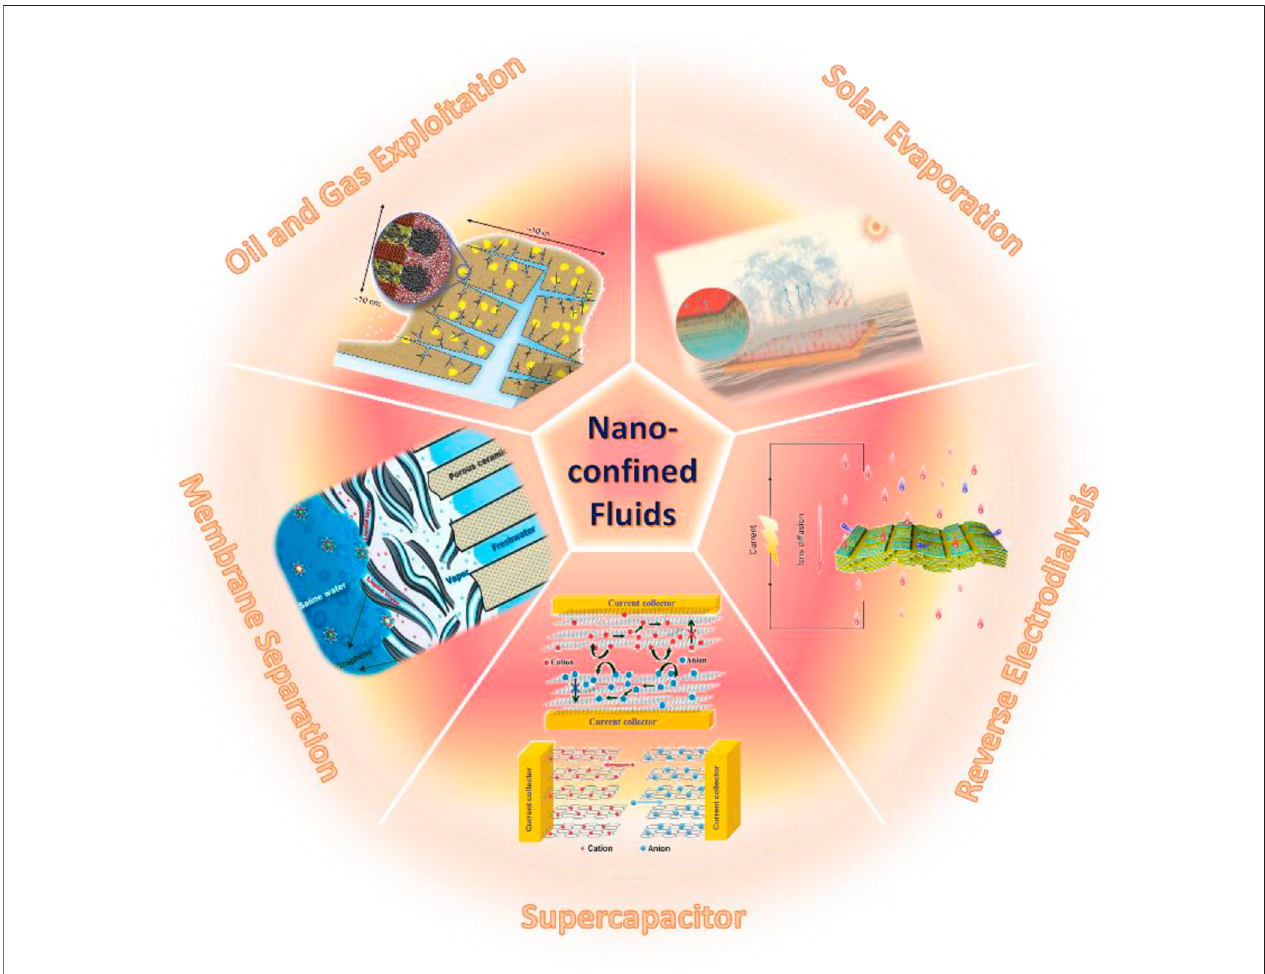
FIGURE1| Schematicillustration ofnanocon fi ned fl uids inenergy applications.Inserted fi gures areadapted fromreferences(Yoo etal., 2011;Leeet al.,2016;Liu et al., 2018; Gong et al., 2021; Zhu et al., 2021).